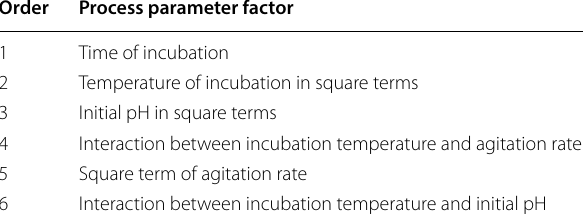
Table 3 Summarization of parameters that significantly influence l -asparaginase production by Stenotrophomonas maltophilia EMCC2297 variant arranged in a descending order Order Process parameter